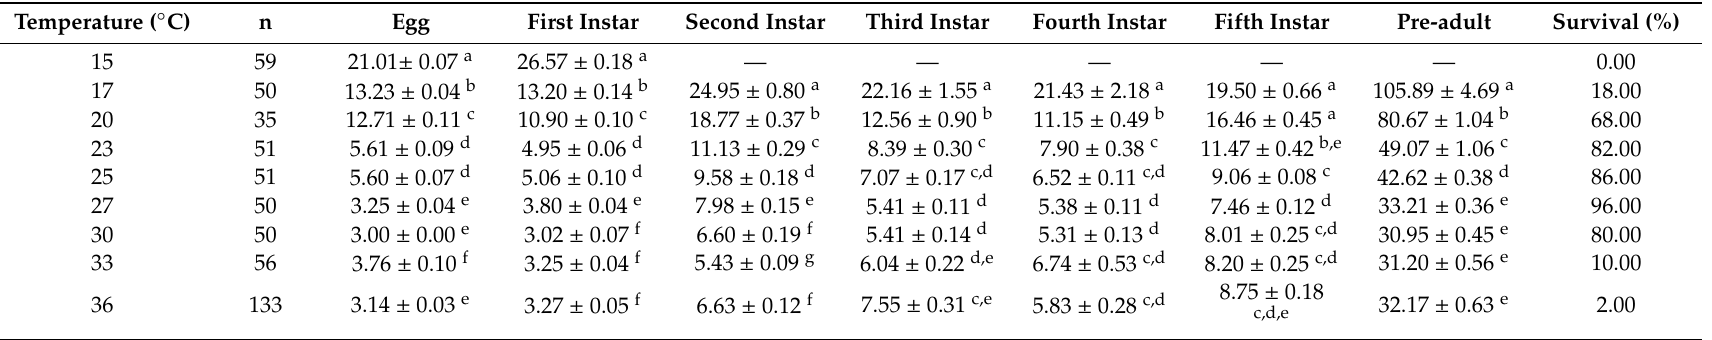
Table 1. Mean developmental time (days ± standard error [s. e.]) and egg-to-adult survival (%) for MN-acclimated Halyomorpha halys at constant temperatures. Temperature ( ◦ C)